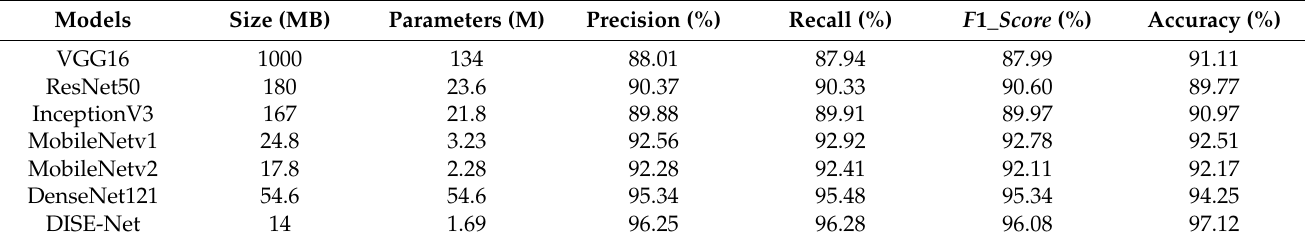
Table 5. Test results of grading detection of maize small leaf spot.